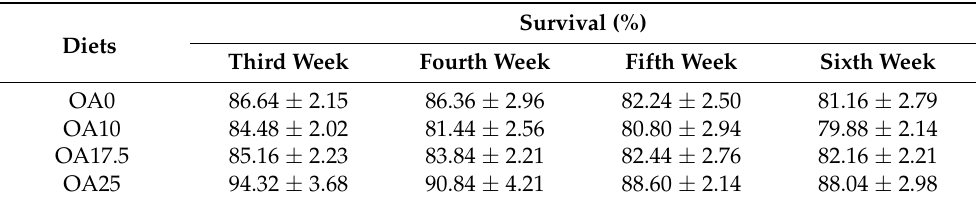
Table 1. Survival (%) of Tenebrio molitor larvae ( ± SEM) fed for six weeks with wheat bran (control) (OA0) and bran fortified with different rates of albedo orange peel waste (10 (OA10), 17.5 (OA17.5), and 25% (OA25)) (n = 8).